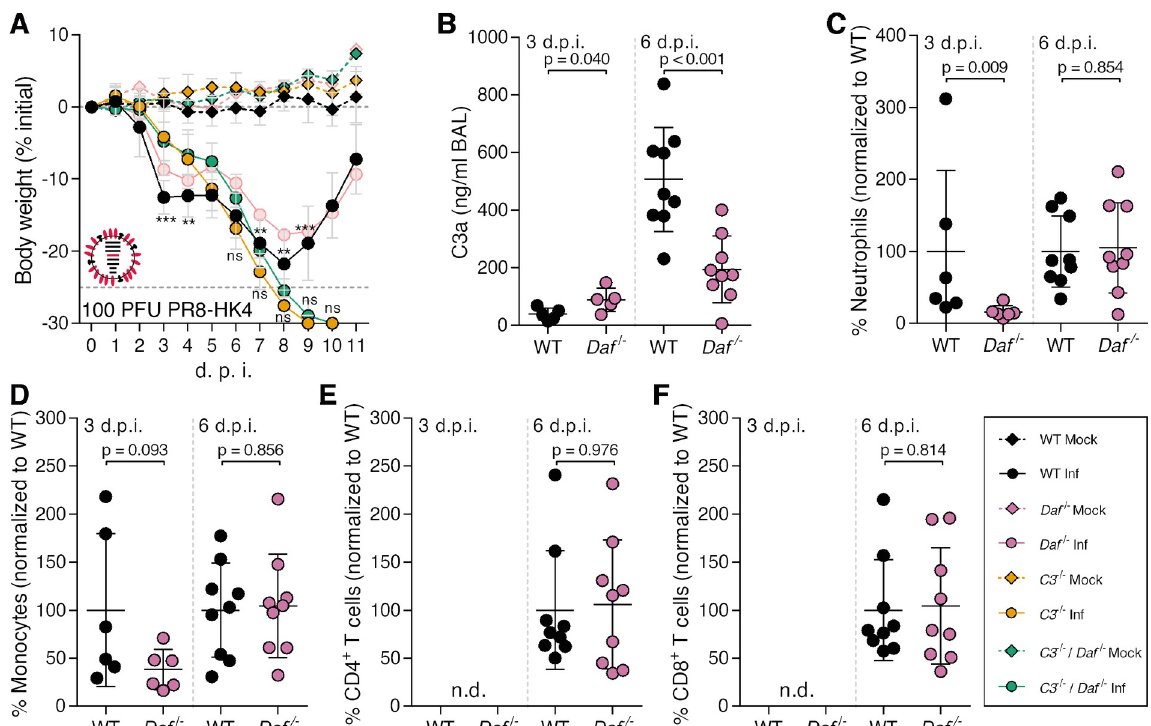
Fig 9. Daf -/- mice present lower complement activation and neutrophil recruitment at 3 d.p.i. upon PR8-HK4 infection. A : Bodyweight loss of C57BL/6J WT, Daf -/- , C3 -/- or C3 -/- / Daf -/- mice infected with 100 PFU of A/Puerto Rico/8/1934 with segment 4 from A/Hong Kong/1/68 (PR8-HK4) (Inf n = 14, n = 10, n = 10, and n = 3, mock n = 4, n = 1, n = 3 and n = 1 for WT, Daf -/- C3 -/- , C3 -/- / Daf -/- and Daf -/- respectively). Results are expressed as mean ± sd. B : C3a levels in BALs of C57BL/6J WT or Daf -/- mice at 3 d.p.i. (n = 5 per group) 6 d.p.i. (n = 9 per group) with 100 PFU of PR8-HK4. Results are expressed as mean ± sd. C, D, E, F : Analysis of neutrophils ( C ), monocytes ( D ), CD4 + T cells ( E ) and CD8 + T cells ( F ) levels in BALs of WT or Daf -/- mice, 3 d.p.i (n = 6 per group) and 6 d.p.i. (n = 9 per group) with 100 PFU PR8-HK4. Samples with non detectable cell levels are noted as n.d.. Results are expressed as mean ± sd from two independent experiments. A representative experiment with absolute values can be found in S3I–S3L Fig. Statistical analysis detailed in materials and methods.